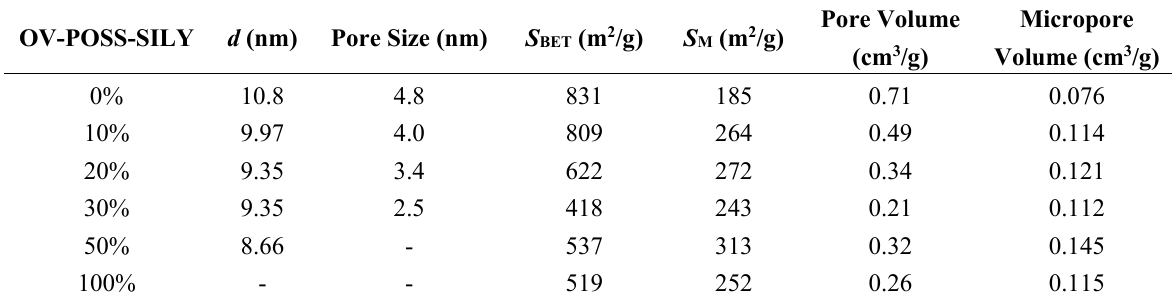
Table 1. Textural properties of mesoporous silicas templated by F127 at various OV-POSS-SILY weight ratios. OV-POSS-SILY d (nm)